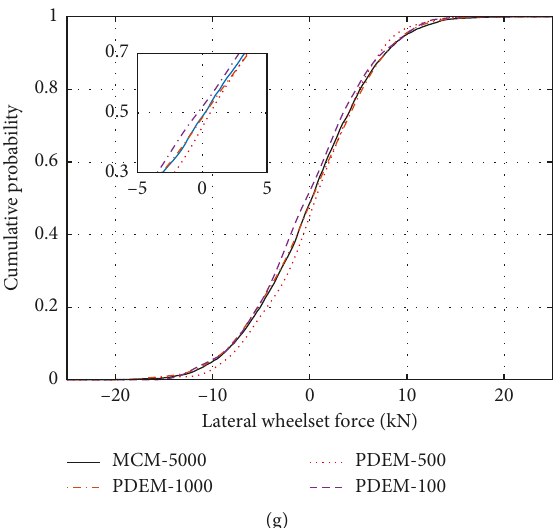
Figure 12: Comparison of cumulative probabilities of the major vehicle-safety evaluation indices. Reduction rate of left wheel load (a) and right wheel load (b). Derailment coefficient of left wheel load (c) and right wheel load (d). Vertical acceleration of car body (e). Lateral acceleration of car body (f). Lateral wheelset force